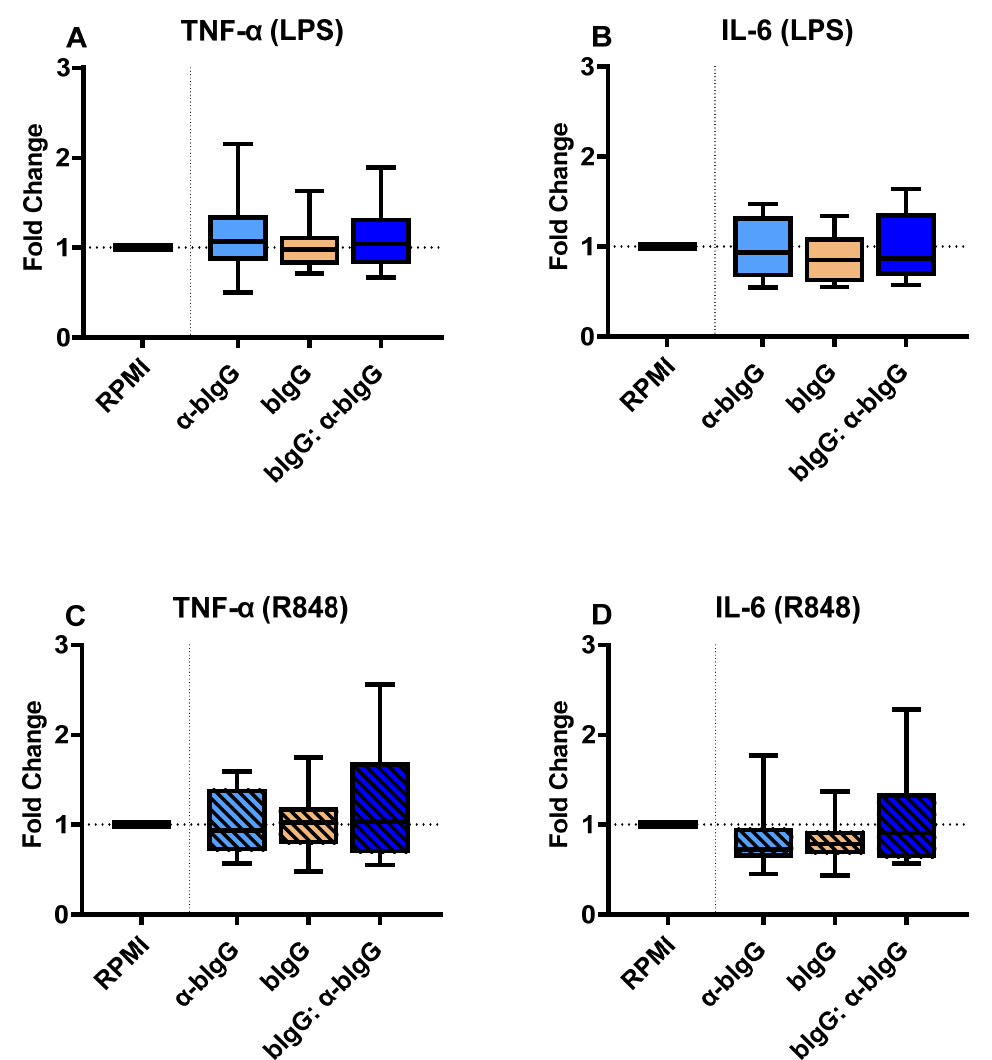
Figure 6. The fold changes in the production of TNF- α ( A ) and IL-6 ( B ) in the cells trained with α -bIgG only (5 µ g/mL) only, bIgG alone (3 µ g/mL), or bIgG: α -bIgG ICs compared to untrained monocytes (RPMI) upon stimulation with LPS and also TNF- α ( C ) and IL-6 ( D ) production after R848 stimulation. The average (range) of cytokines in the RPMI controls of all 8 donors tested were 1740 (719–4825 pg/mL), 3279 (1044–7232 pg/mL), 3508 (1839–7434 pg/mL), and 8961 (3732–14,230 pg/mL) for conditions A to D, respectively. The boxes represent 50% of the data, and the line is the median value where upper and lower whiskers present the upper and lower 25% of the data, respectively.